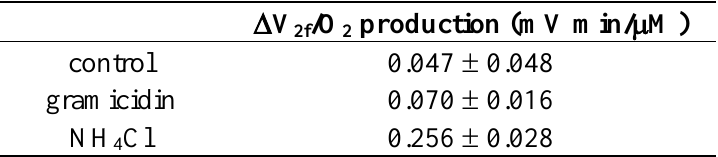
Table 1. The ratio of  V gramicidin entries are similar, suggesting  V gramicidin induced uncoupling. The NH ratio. Error is given as standard